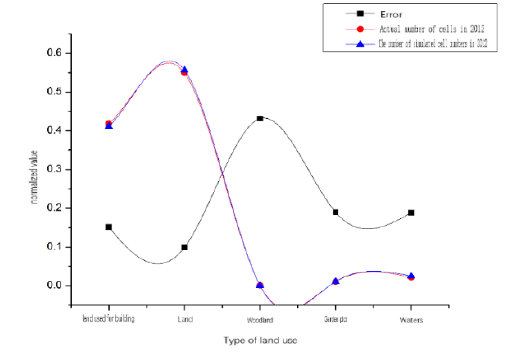
Figure7. Error Analysis of Simulation